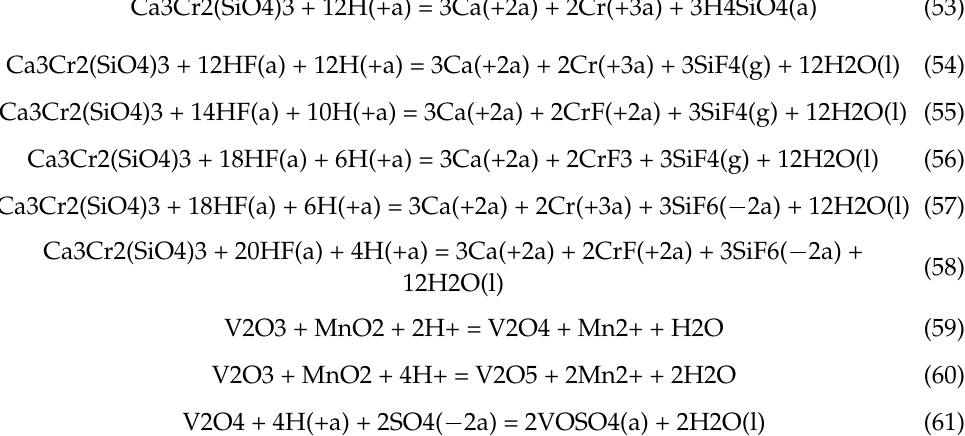
Figure 4. Eh–pH relationship of Cr-H 2 O system. Gibbs Free Energy of Vanadium Bearing Garnet Dissolution Reaction Vanadium in garnet is mainly in the form of V 2 O 3 (V (III)), and after being oxidized by an added oxidant, it is mostly in the form of V 2 O 4 (V (IV)). To explore the mechanism of the enhanced acid-leaching process of garnet, the Gibbs free energy changes of the dissolution reaction of Ca 3 Cr 2 (SiO 4 ) 3 and V 2 O 4 were calculated. Equations (49)–(54) and (57)–(61) refer to the dissolution reactions of Ca 3 Cr 2 (SiO 4 ) 3 and V 2 O 4 , respectively, whereas Equations (55) and (56) refer to the reaction of adding an oxidant to convert low-valence vanadium into high-valence